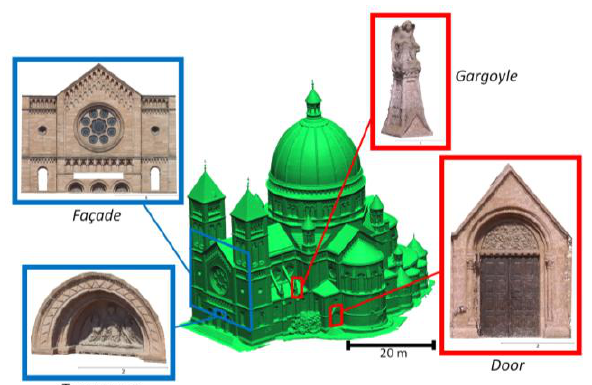
Figure 4. The four samples within the St-Pierre dataset which were compared against the TLS data. The blue squares indicate acquisition by Albris , while red squares indicate acquisition by Phantom 3